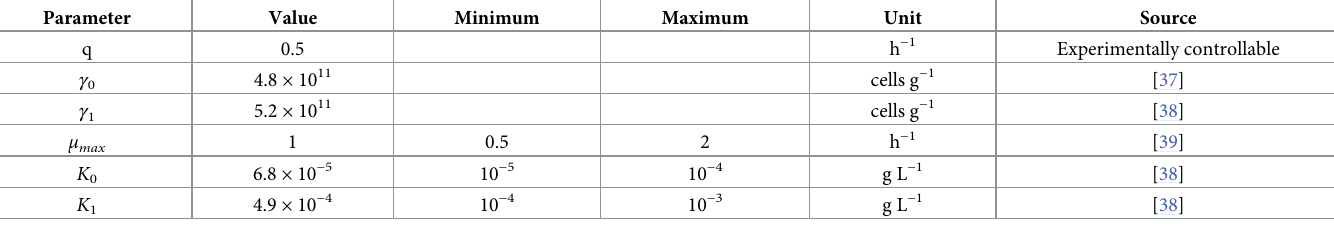
Table 1. Parameters for the auxotroph system. Nominal parameter values, along with minimum and maximum bounds, used for simulations of a bacterial culture.